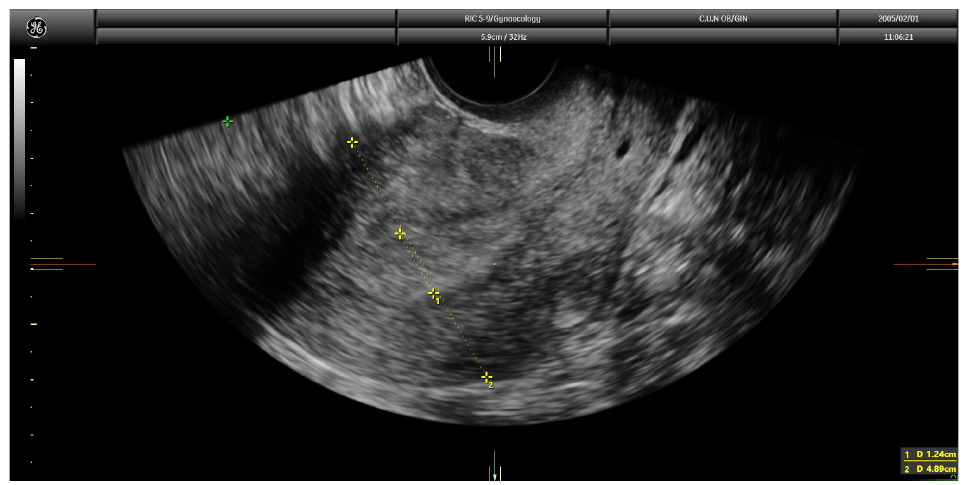
Figure 2. Transvaginal ultrasound showing a case of superficial infiltration in endometrial cancer using the Karlsson’s method. The ratio endometrial thickness/uterine anteroposterior diameter was 25.3%.